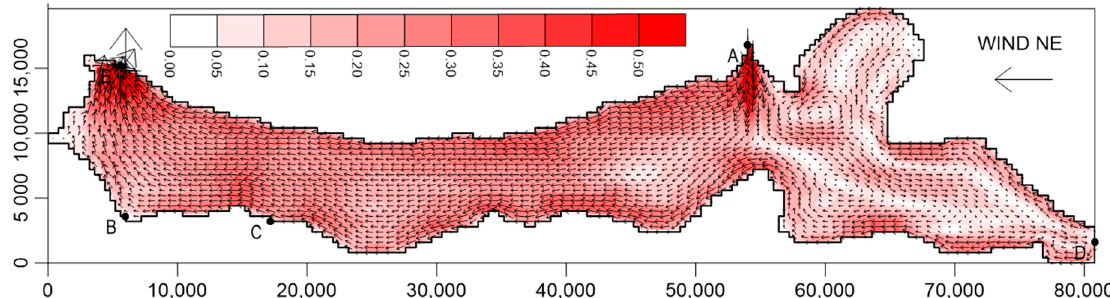
Figure 9. Water surface elevation (m a.s.l.) after 12 hours of a NE wind at a speed of 12 m s -1 and with the new artificial strait at point E (dimensions in meters).